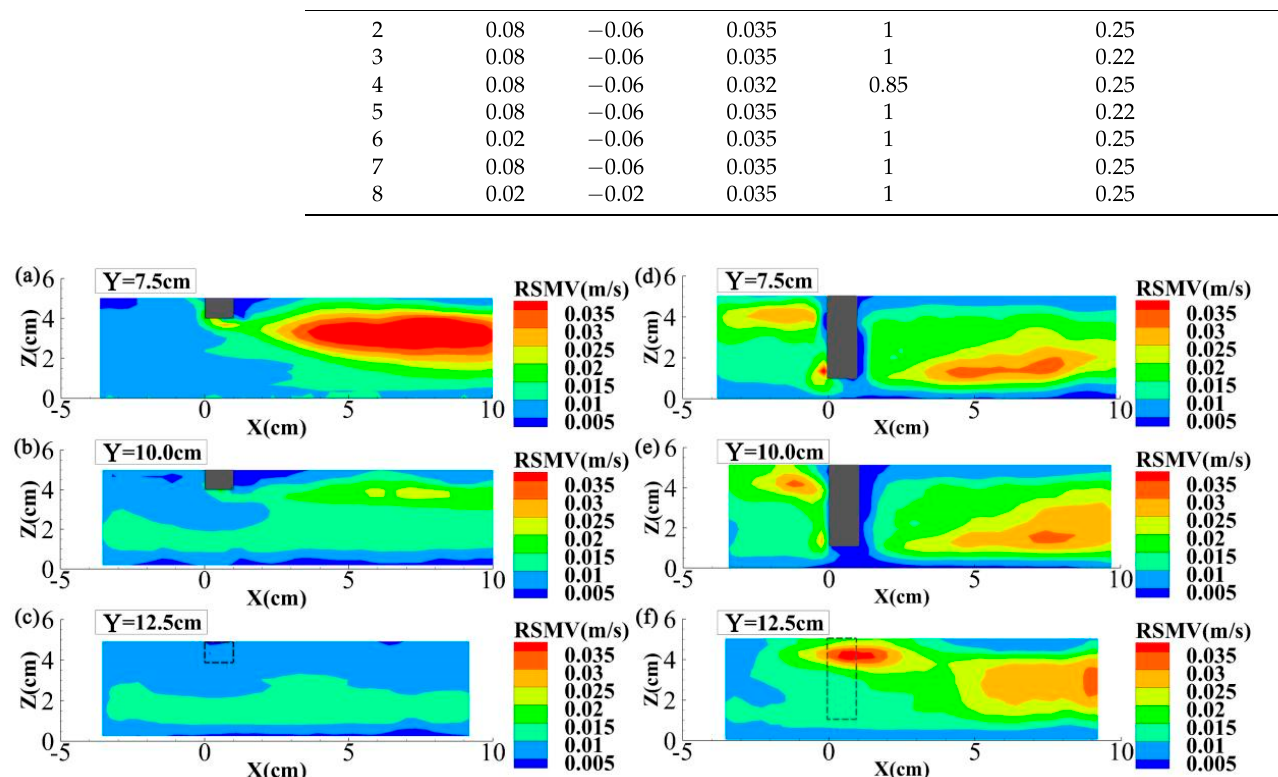
Table 3. Maximum or minimum (in the reverse direction) values for experimental parameters. In the Backflow Zone On the Right Side of the Dike Case No.